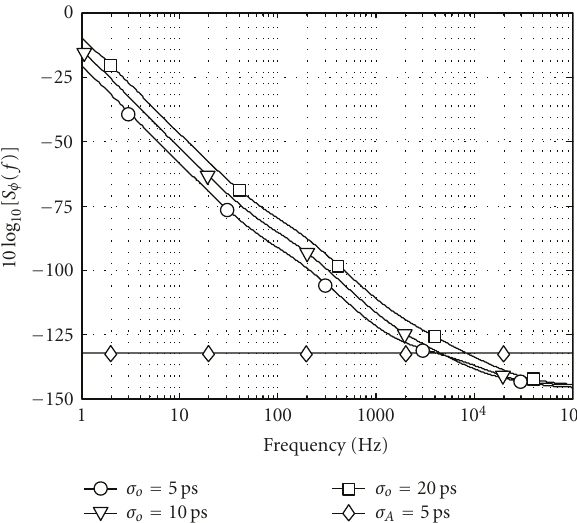
Figure 2: Cyclostationary noise instantaneous PSD in the example channel.